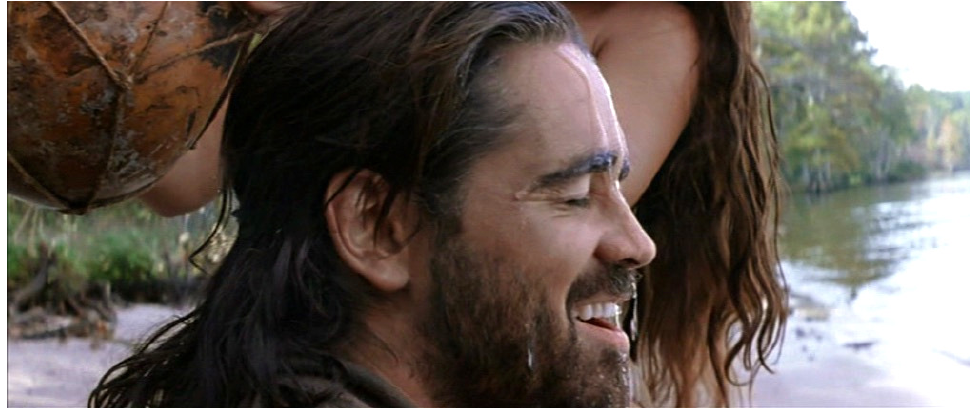
Figure 14: Smith is groomed by a tribesman.